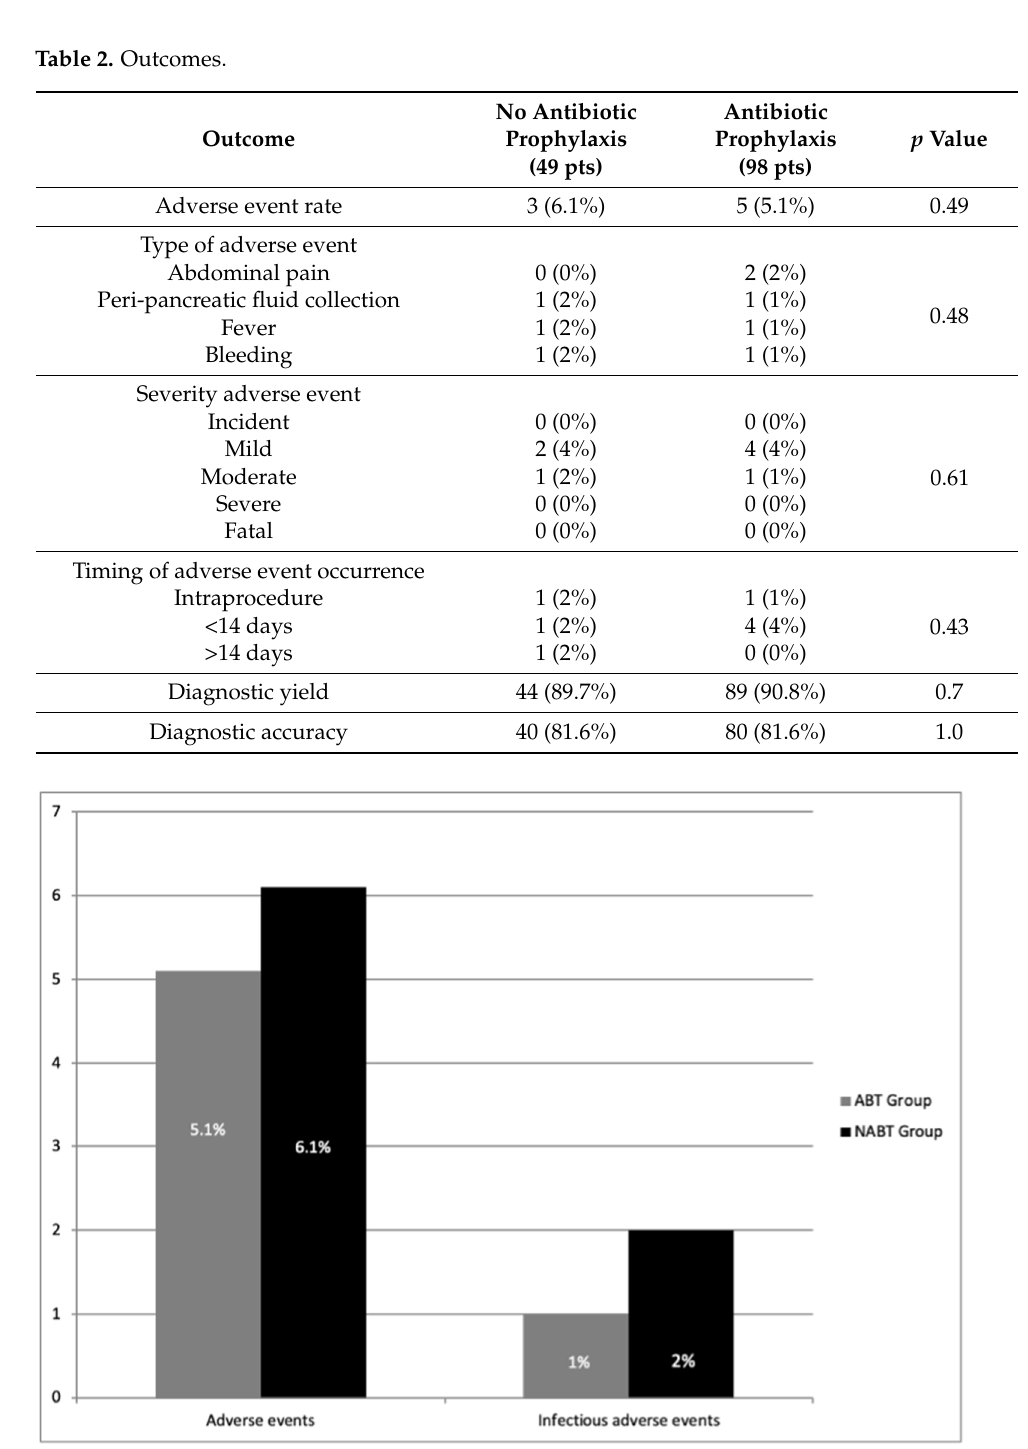
Figure 3. Comparison of overall and infectious adverse events between the two study groups.